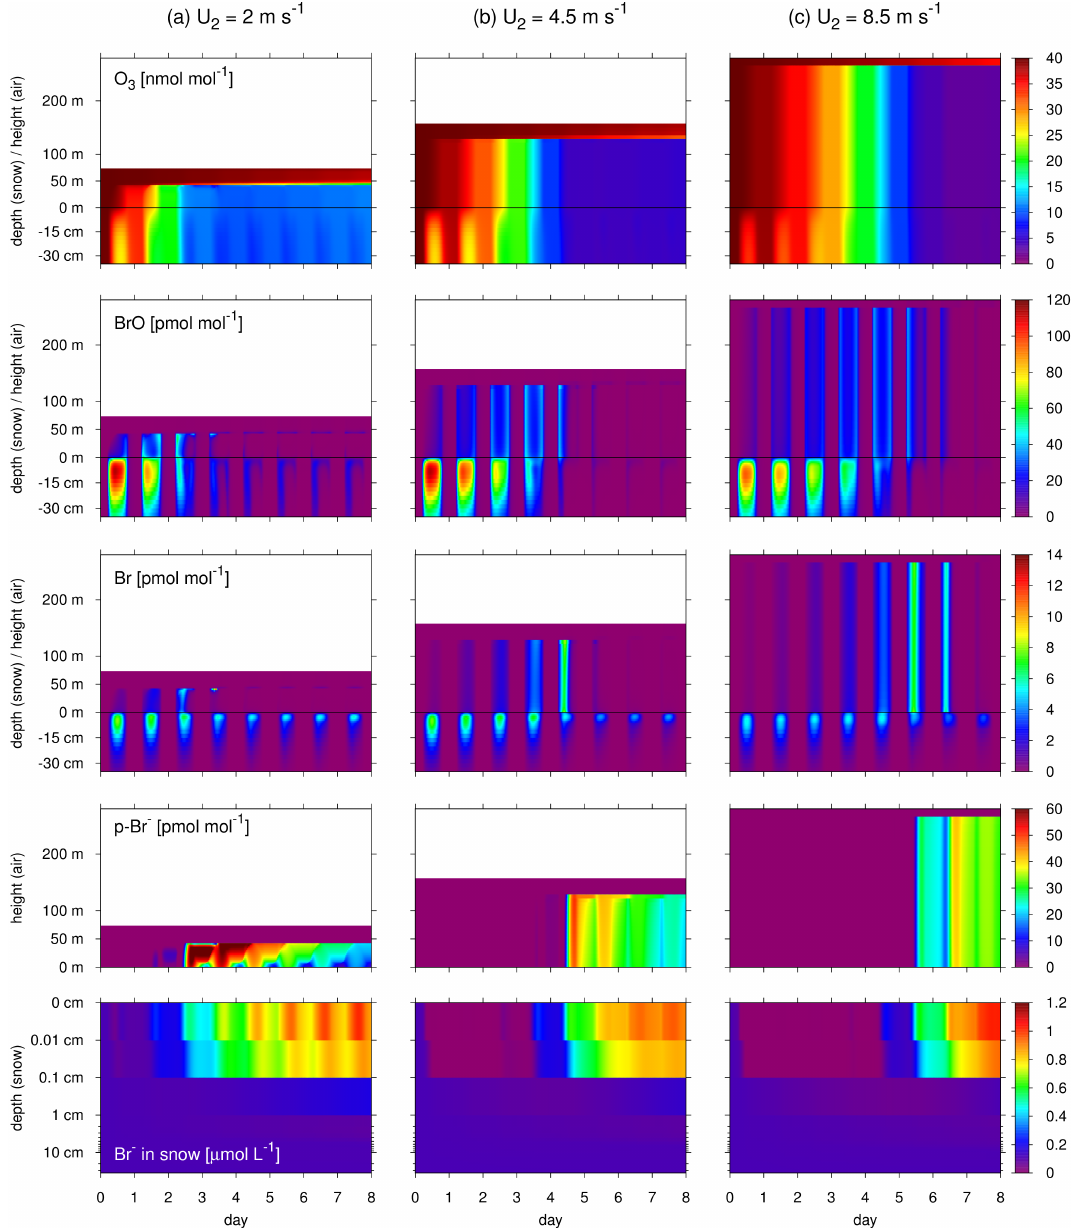
Fig. 4. Time-height cross sections for the mixing ratios of O 3 (top row), BrO (second row), Br-atom (third row), and aerosol bromide (p-Br − , fourth row), and for the bulk concentrations of bromide in snowpack grains (bottom row) from model runs with U 2 = 2ms − 1 (a) , 4.5ms − 1 (b) , and 8.5ms − 1 (c) . N = 0.031s − 1 for all the model